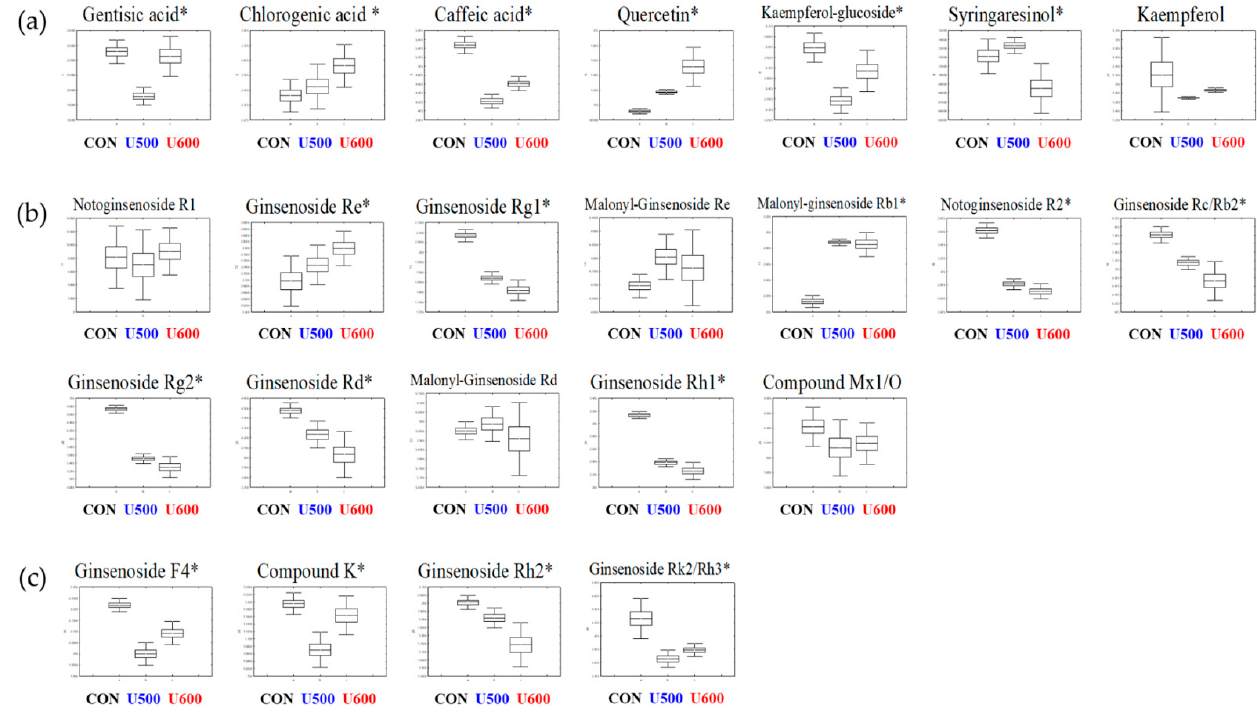
Figure 3. Box and whisker plots of significantly different metabolites among GBPs obtained after different UHP processing treatments. ( a ) Phenolic compounds; ( b ) polar ginsenosides; ( c ) less polar ginsenosides. Relative contents of metabolites of GBPs were calculated as a relative peak area in UHPLC-LTQ-Orbitrap-MS/MS analysis. The metabolite content corresponds to the relative peak area plotted in the Y -axis. ( Line , mean; box , Standard error; whisker , standard deviation) The GBP obtained after different UHP processing treatments plotted in the X -axis. (CON, control; U500, 500 MPa; U600, 600 MPa) * p -value < 0.05.